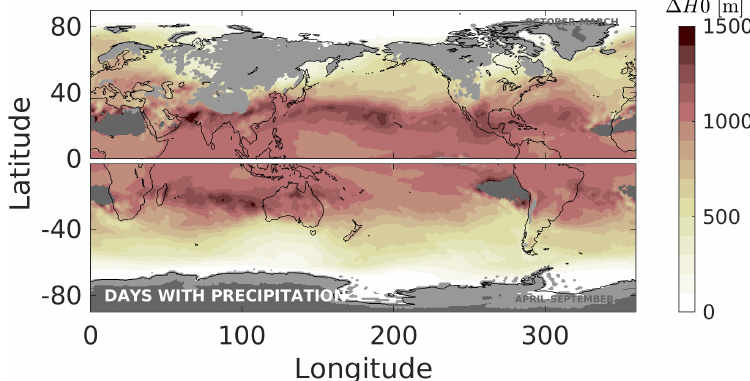
Figure 5. ( a ) The gray bars show the histogram of the observed H 0 at Santo Domingo during wet days and the gray line is the fitted normal distribution. The blue, red and purple lines are the fitted normal distribution of H 0 (during wet days) for present and future climate (2071–2100 under RCP8.5 and RCP4.5), respectively, simulated by the CMCC-CM model and interpolated to Santo Domingo. ( b ) Evolution of the CMCC-CM simulated H 0 distribution for days with precipitation, during different decades in the 21st century along the coast of central Chile. Circles indicate the mean of distribution and whiskers the upper and lower quartiles. The blue line and light blue shading are the present climate mean and interquartile range of H 0 (wet days) based on CFSR data. The gray line indicates the 97.5th percentile of terrain elevation.